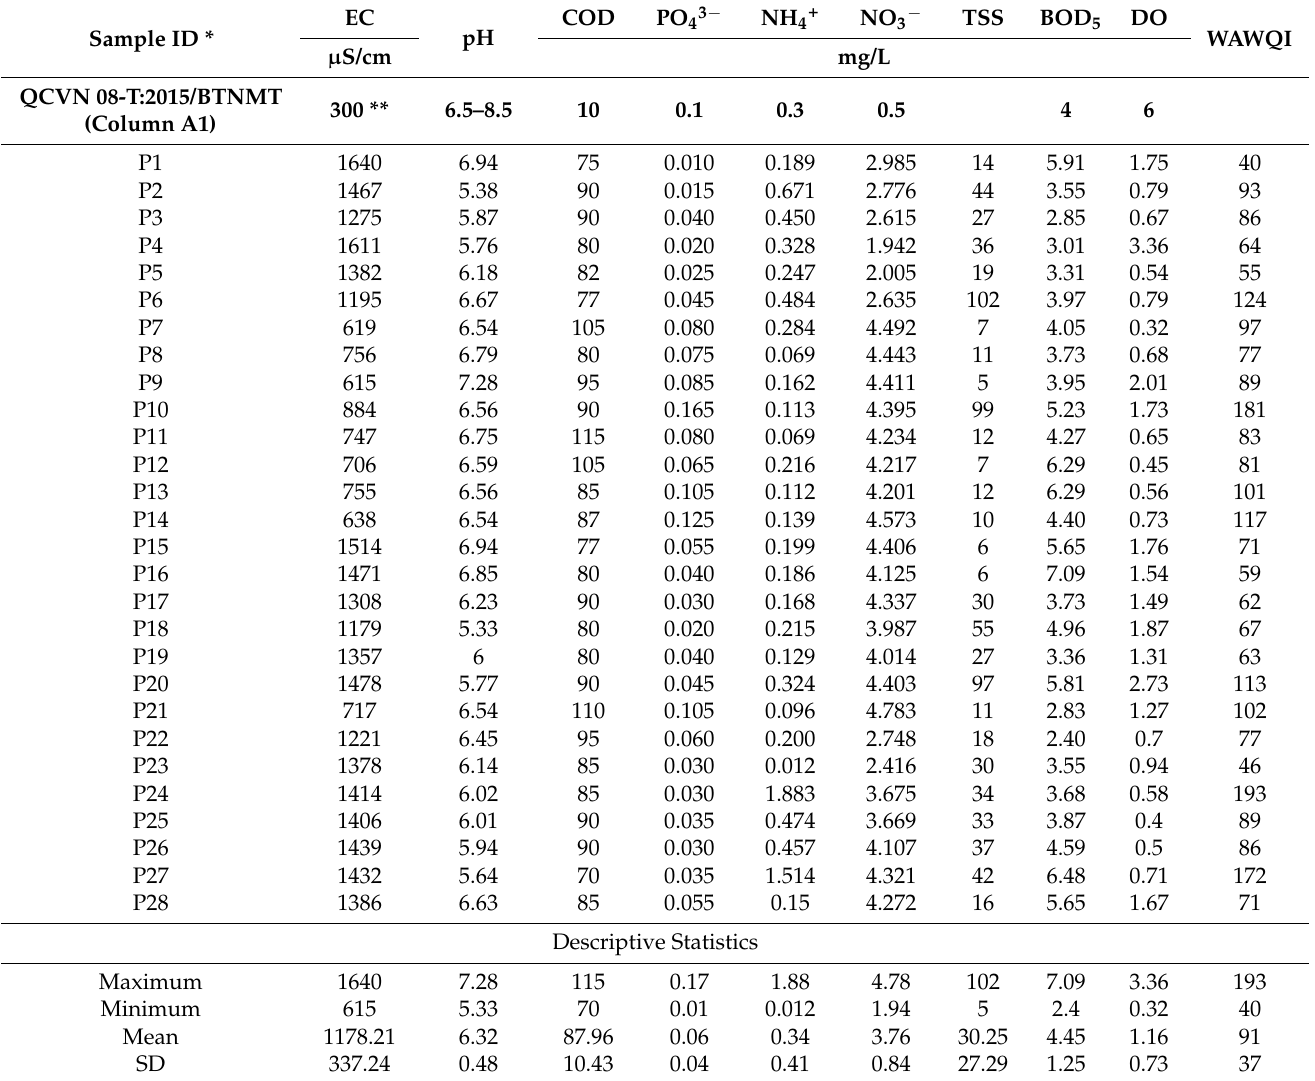
Table 9. Calculation of WAWQI for data at MPMF in Wet season